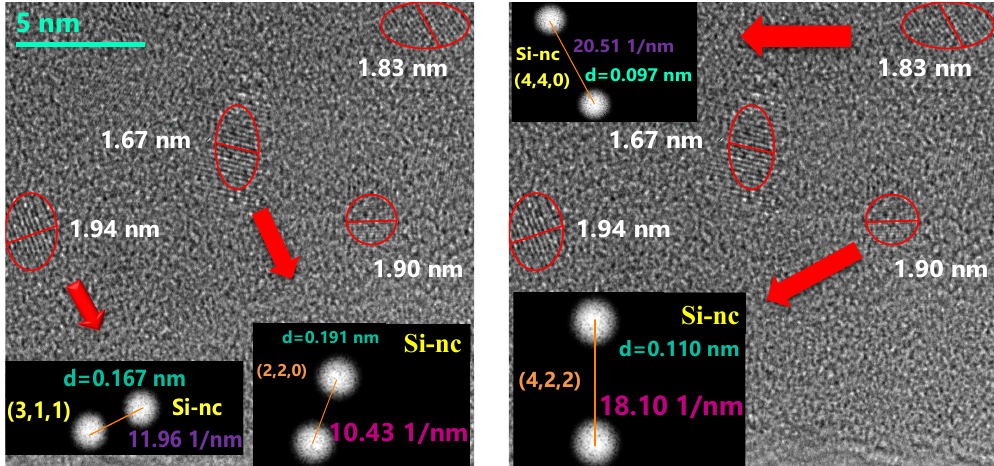
Figure 18. HRTEM micrograph of the D1´ SiO X film with crystallographic orientations.